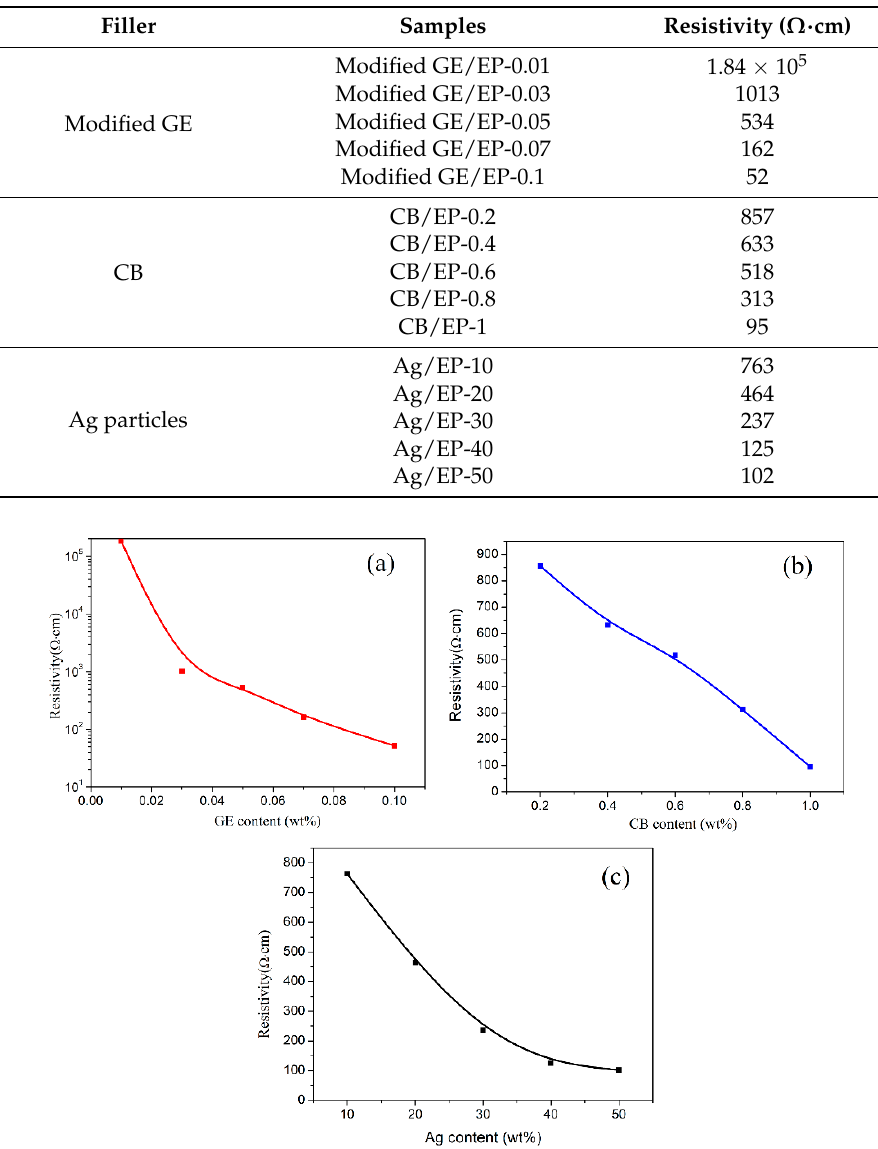
Figure 10. The resistivity of as-prepared modified GE/EP, CB/EP, and Ag/EP composites with different contents of fillers.